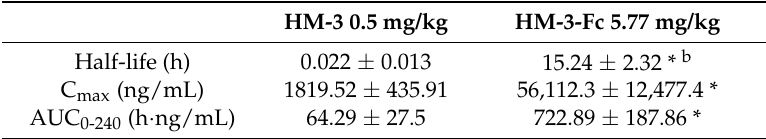
Table 3. Pharmacokinetic parameters of HM-3 and HM-3-Fc in cynomolgus a . HM-3 0.5 mg/kg